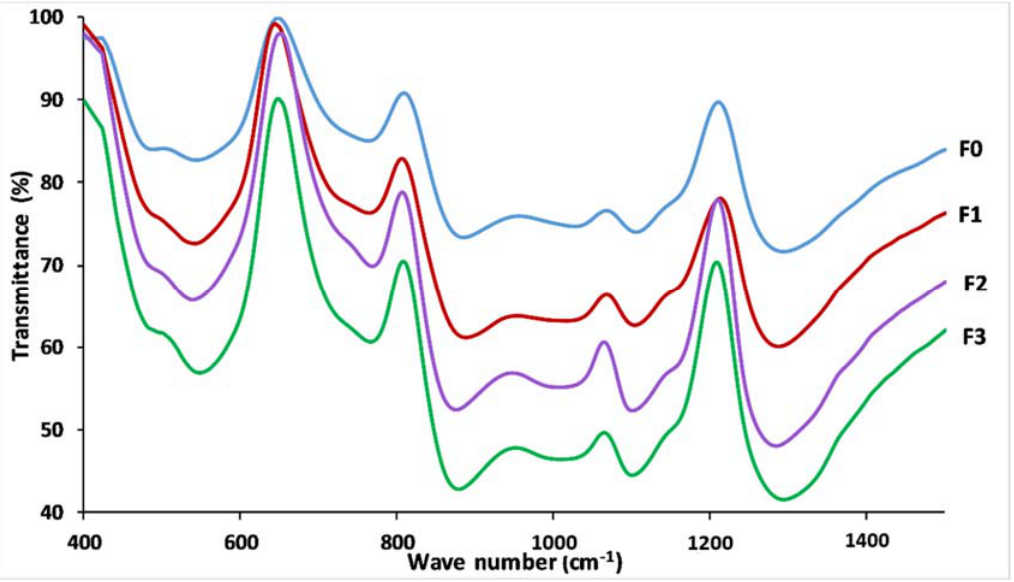
Figure 6. FTIR spectra of prepared glasses.